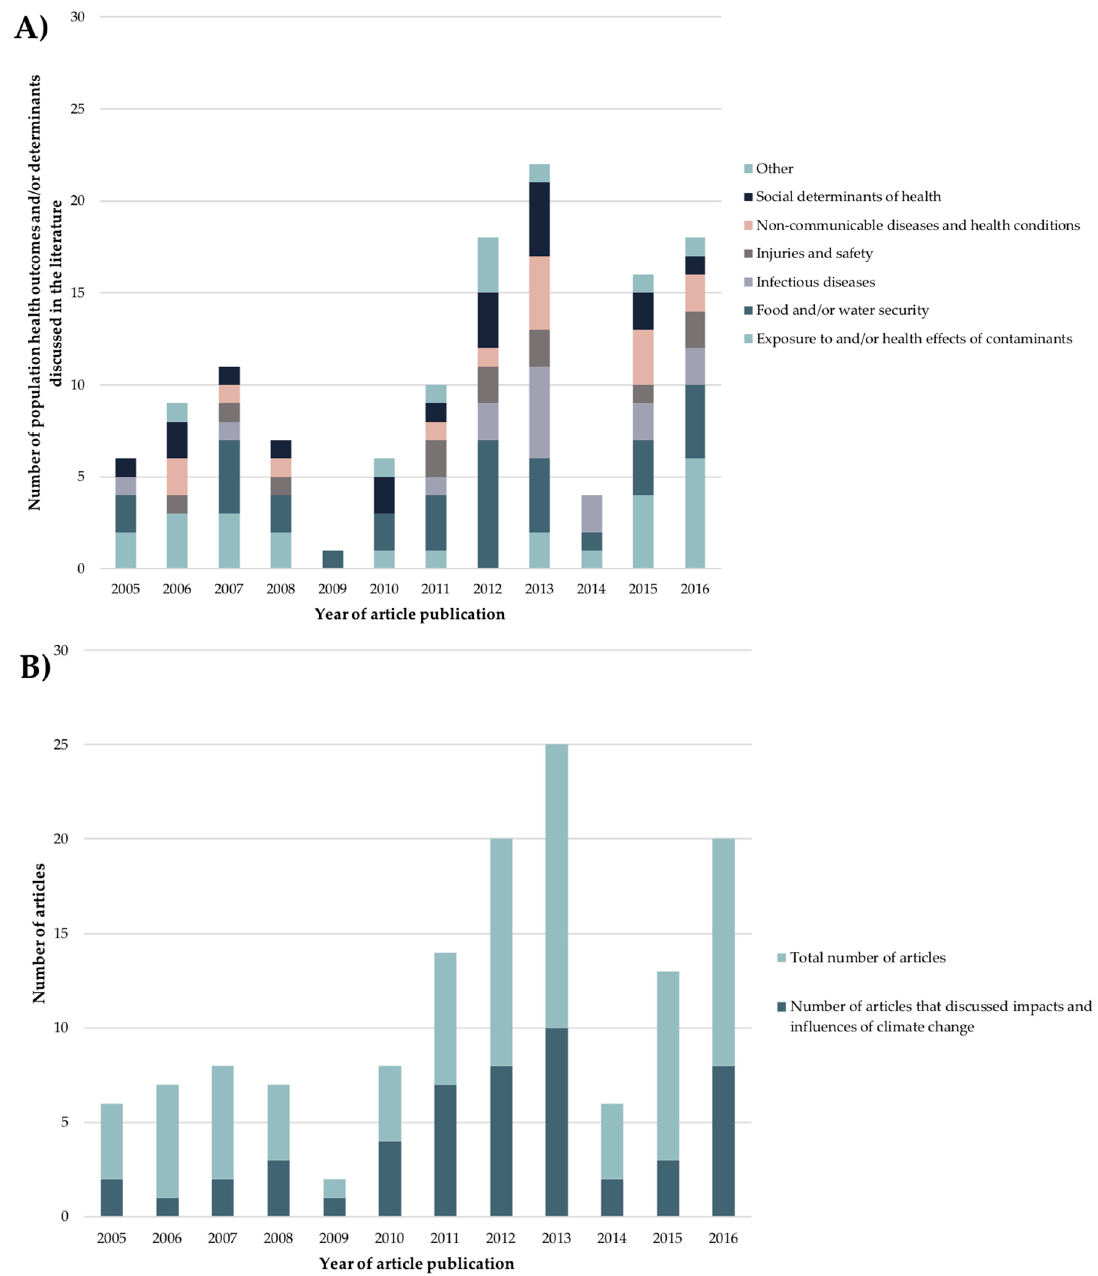
Figure 3. Timeline showing the year of article publication for literature on integrated surveillance for Circumpolar Arctic and Subarctic regions, stratified by ( A ) specific population health outcome or determinant, and ( B ) the number of articles discussing the impacts and influences of climate change on population health. Categories are not mutually exclusive.